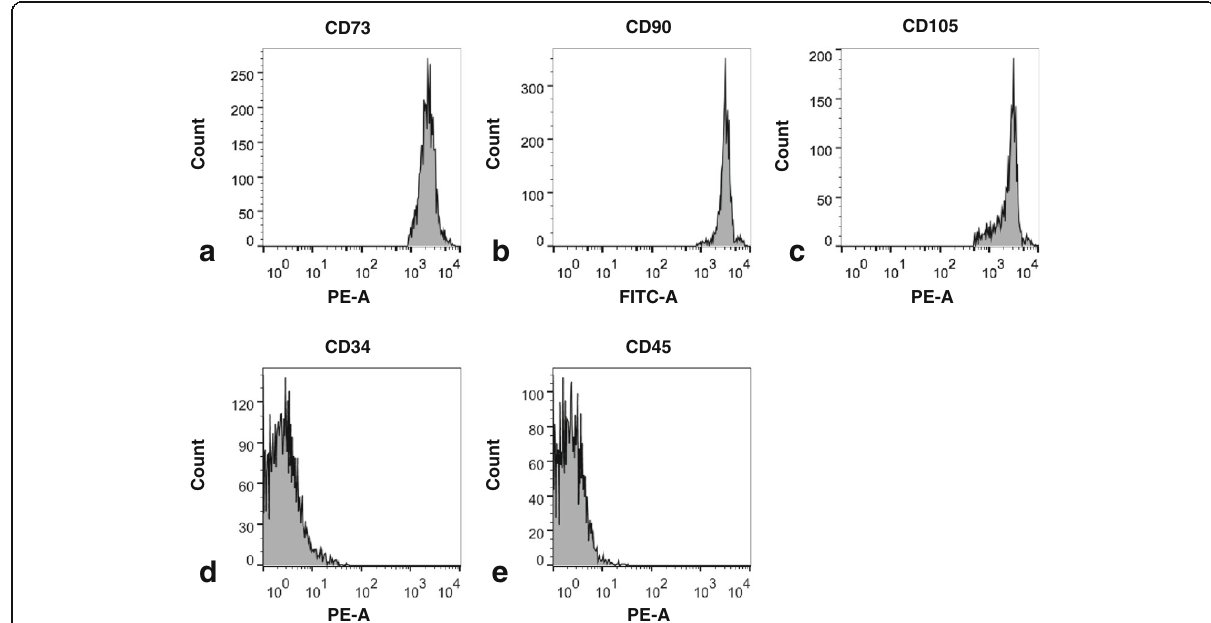
Fig. 1 Flow cytometry analysis of cell surface marker expression on hUC-MSCs. hUC-MSCs were cultured in high glucose α -MEM containing 10% FBS, 100 U/ml penicillin and 0.1 mg/ml streptomycin and were passaged for two times. Then cells were analyzed by flow cytometry ( n = 3). The data presented here were representative of all sample obtained in 6 donors. a : CD73, b : CD90, c : CD105, d : CD34, e :